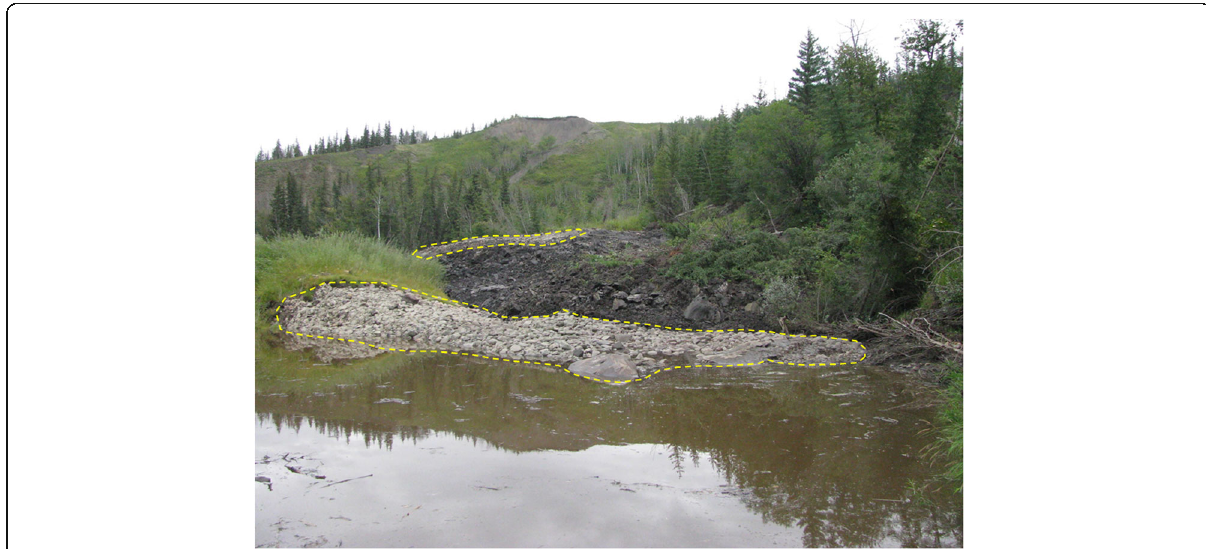
Fig. 11 The 2013 Pouce Coupe River landslide and dam, captured at the Landry Road bridge, looking downstream. The yellow polygons delineate uplifted channel alluvium. (Source: British Columbia Ministry of Transportation and Infrastructure, August 22, 2013; reproduced with